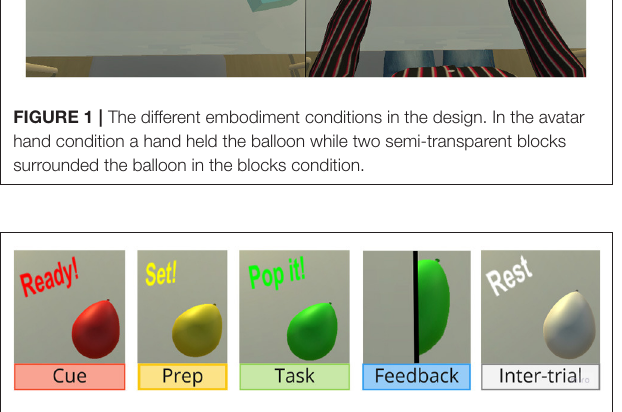
FIGURE 2 | The visuals of the balloon that changed color during the five interaction phases in a traffic light style and then to white for the inter-trial